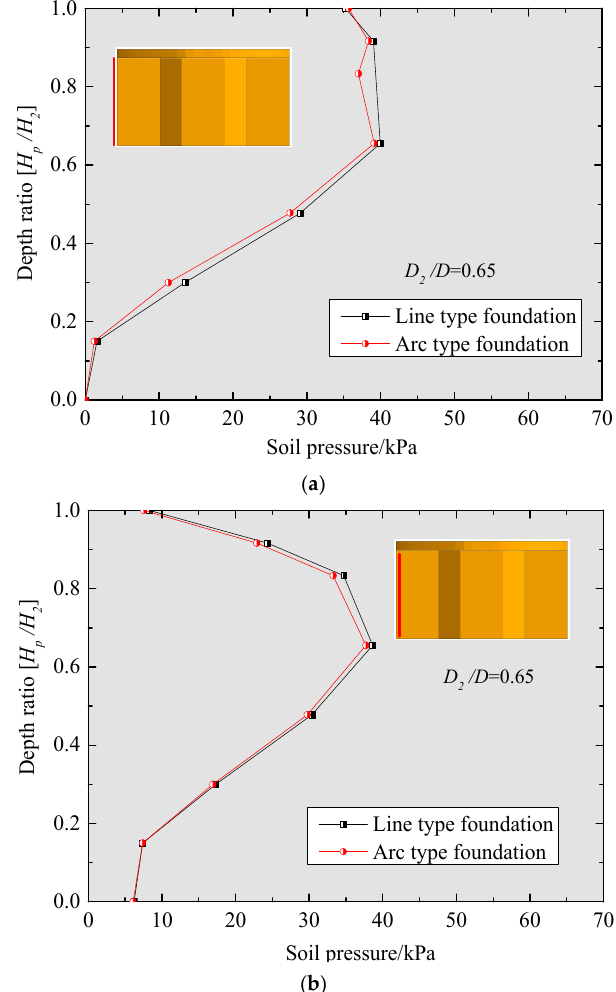
Figure 15. Soil pressures on the back bucket: ( a ) Outside skirt; ( b ) Inside skirt.